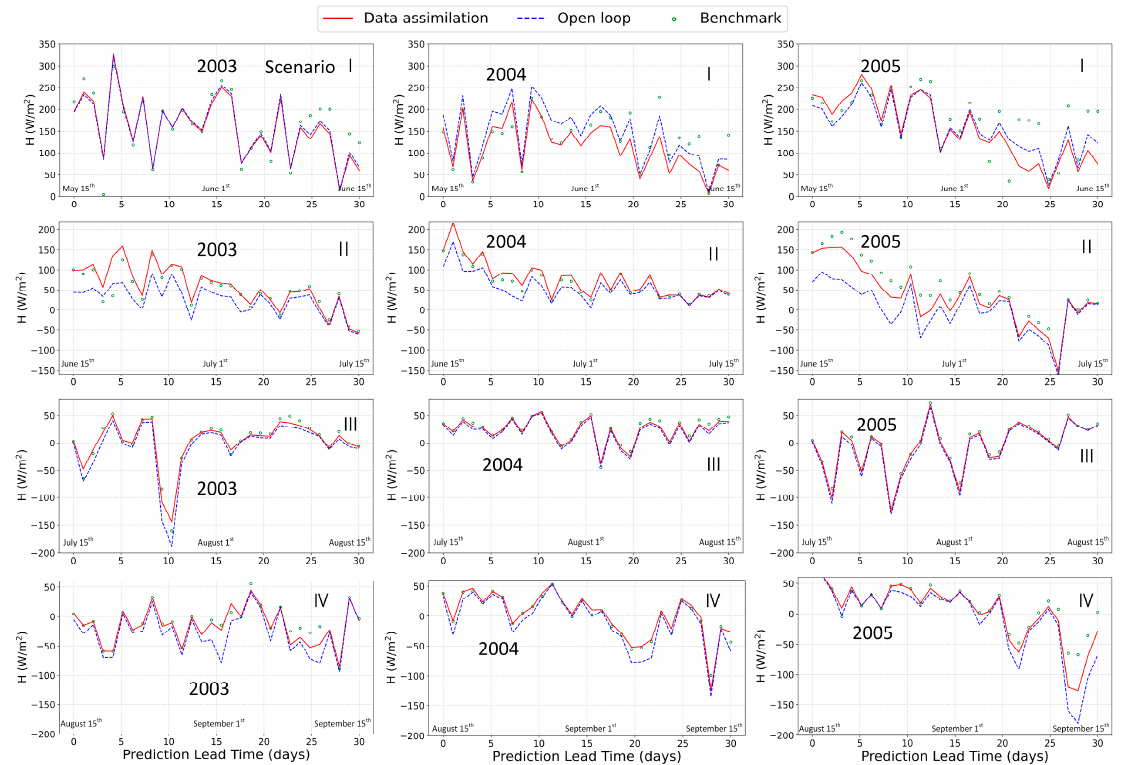
Table 2. NIC RMSD of sensible heat fluxes in different assimilation scenarios (I–IV) in 2003, 2004, and 2005. Positive NIC RMSD numbers are marked in bold.